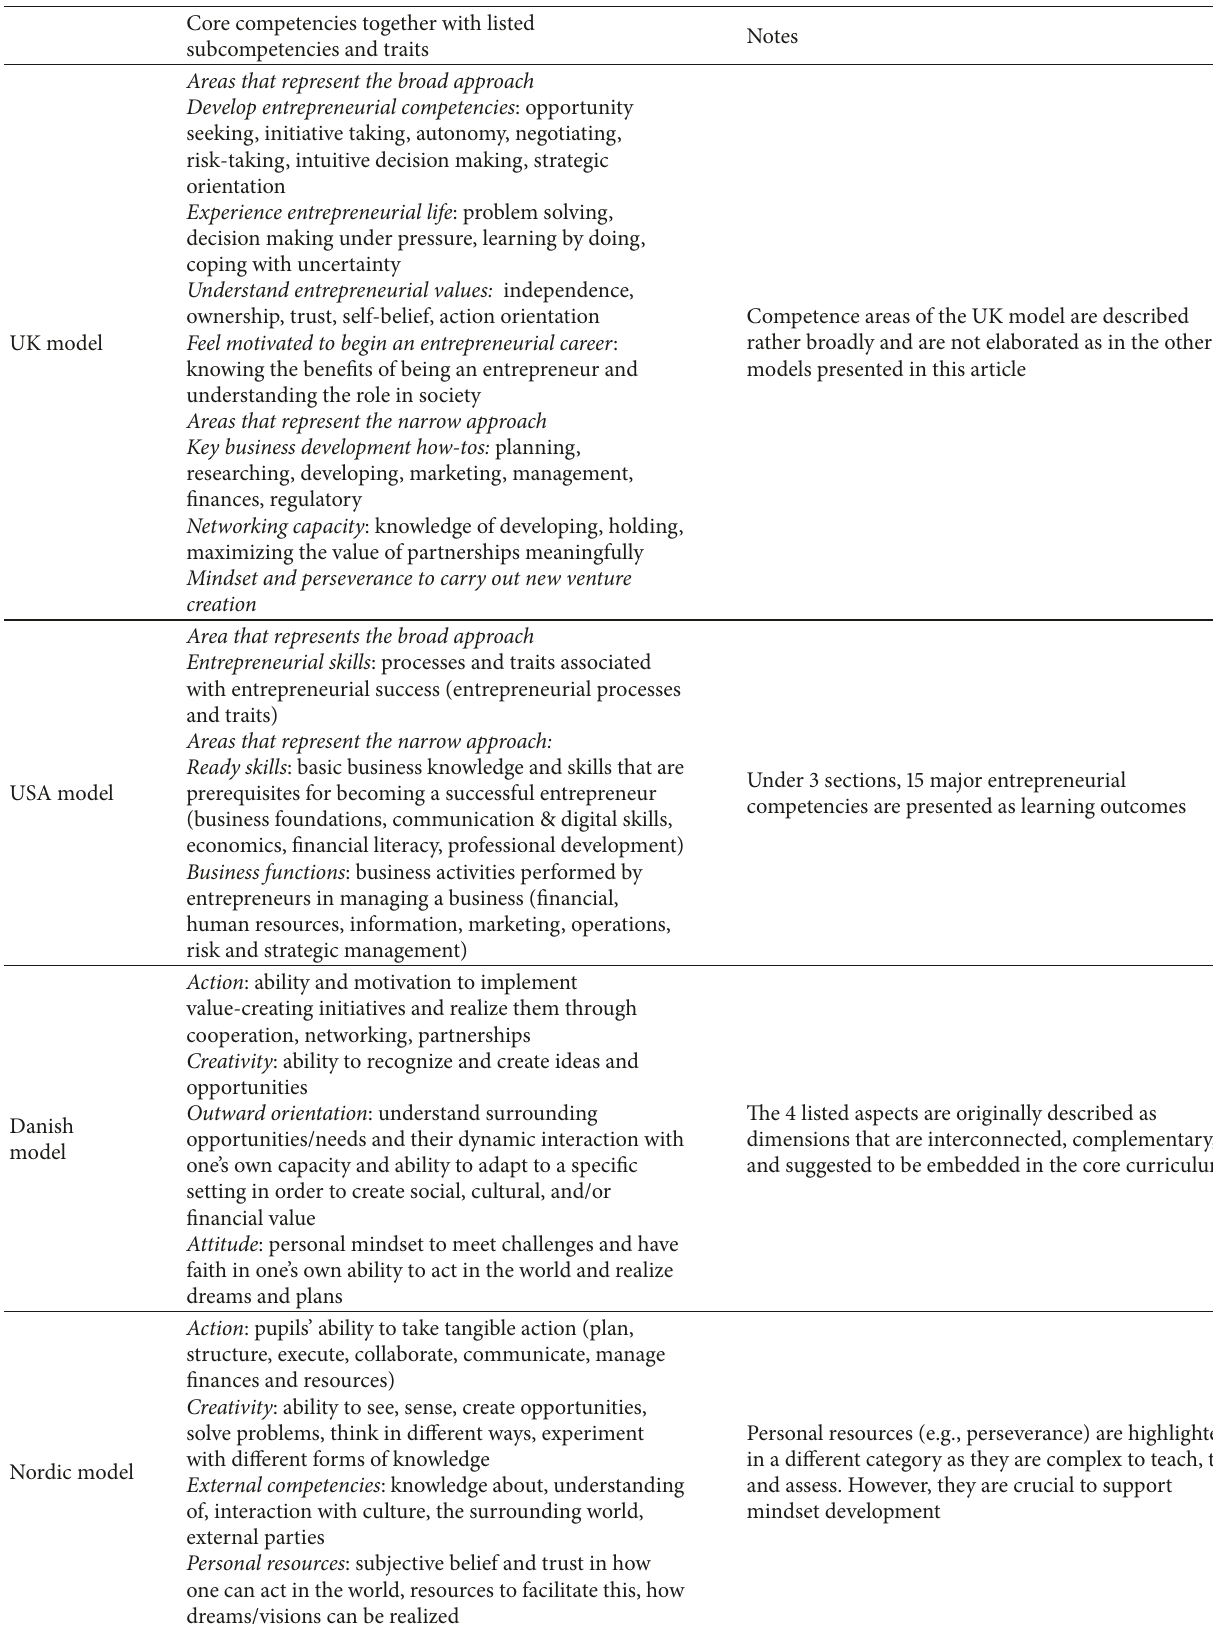
Table 4: Core competence areas and stated subcompetencies of analyzed EE competence models. Core competencies together with listed subcompetencies and